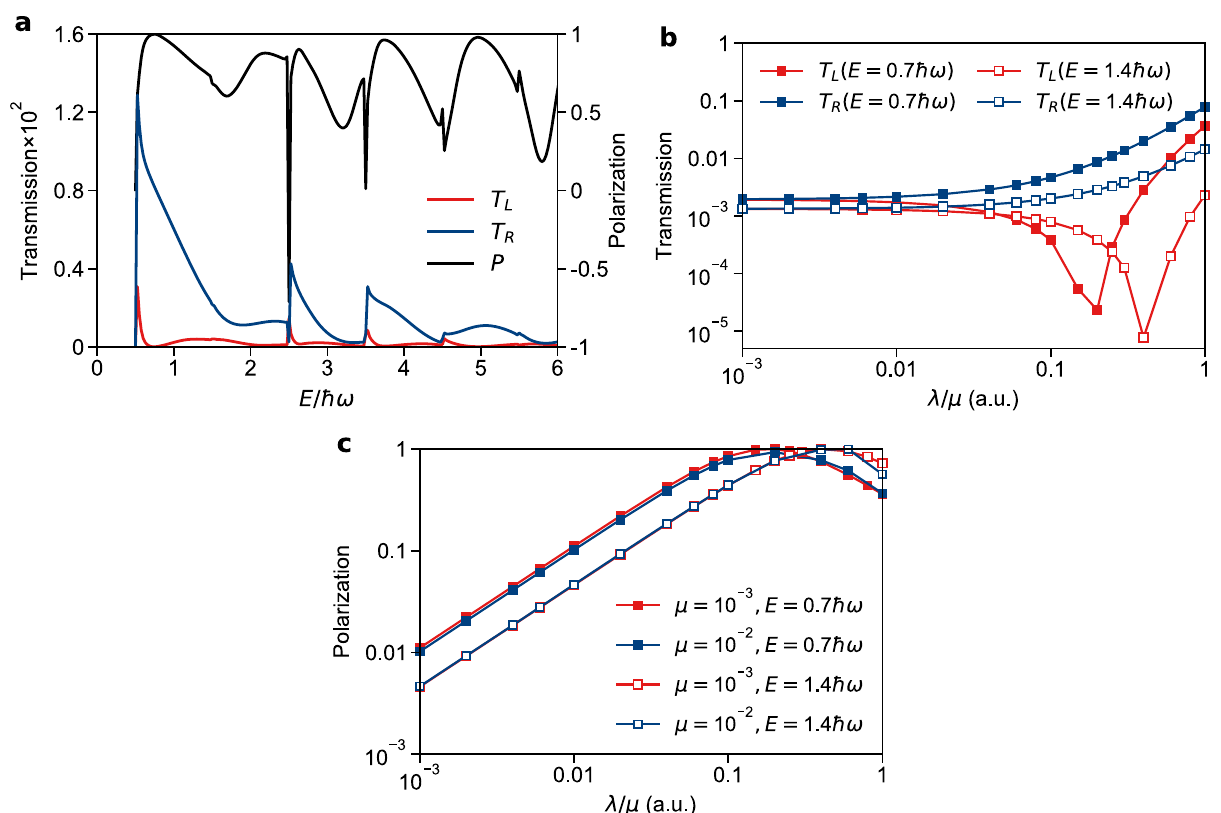
Fig. 2 Transmission rates ( T L and T R ) and spin selectivity P = ( T R − T L )/( T R + T L ) for dynamics along the Hamiltonian in Eq. (7). a T L , T R , and P as functions of the incoming energy. Note that the selectivity is very large, almost always >50% and often close to 100%. Here the model parameters (de fi ned in Eq. (8)) are λ = 10 − 3 and μ = 2 × 10 − 4 . b T L and T R as function of λ / μ with two fi xed incoming energies E = 0.7 (cid:1) h ω and 1.4 (cid:1) h ω and μ = 10 − 3 . While an increase in SOC ( λ ) always leads to an increase in T R , this monotonic behavior is not true for T L , leading to huge selectivity. c P as a function of λ / μ at incoming energies E = 0.7 (cid:1) h ω , 1.4 (cid:1) h ω and μ = 10 − 3 , 10 − 2 . Here P has little dependence on μ alone but depends on the reduced parameter λ / μ . The model parameters (de fi ned in Eq. (8)) are: A = 0.02, ω = 0.01, M = 10 3 , ϵ 1 = 2.5, ϵ 2 = 2.5, r 0 = 2 (all in atomic units). The source data can be found in Supplementary